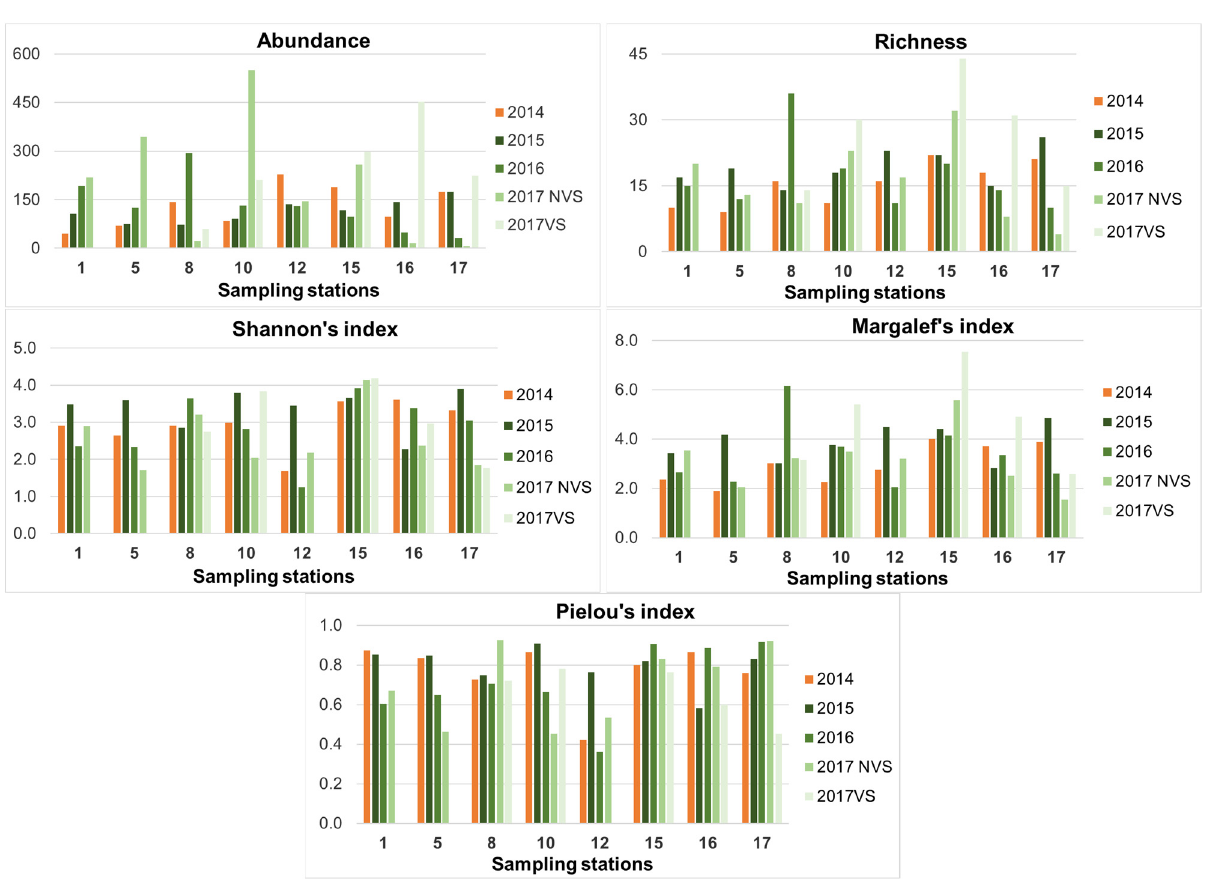
Figure 3. Ecological indices at each station from 2014 ante transplant operations to 2017 post- transplant operations (vegetated –VS- and non-vegetated stations –NVS-).